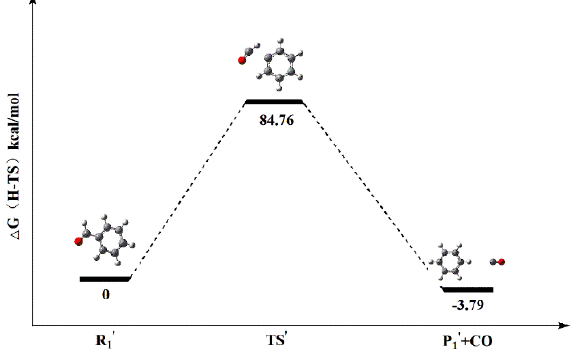
Figure 9. Sketch map of the reaction potential energy profile of reaction path b.